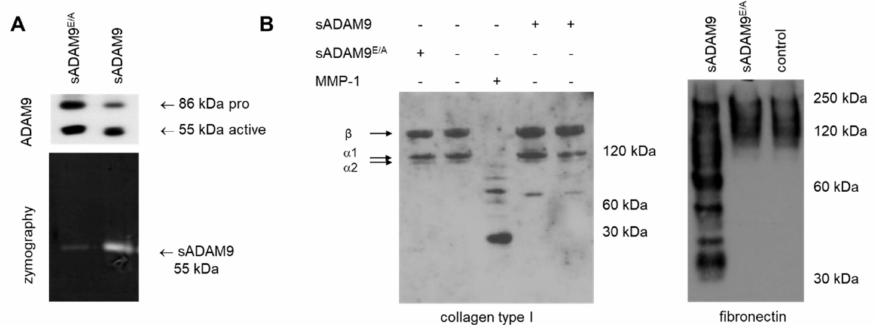
Figure 3. Collagen type I is a substrate of recombinant ADAM9 ( A ) Upper insert, detection of purified ADAM9 by western blot using anti-ADAM9 antibodies. In the lower panel, gelatin zymography analysis shows the high gelatinolytic activity of the catalytic active 55 kDa (sADAM9) and low of the catalytically inactive ADAM9 (sADAM9E / A). ( B ) Enzymatic processing of fibronectin or collagen type I by recombinant ADAM9s as assessed by immunoblotting. 500 ng of recombinant collagen type I or fibronectin were incubated alone (control, − ) or without ( − ) and with one µ g of recombinant sADAM9 or sADAM9E / A ( + ) for 16 h in substrate bu ff er. Incubation of collagen with 500 ng MMP-1 used as a positive control. Molecular weight markers are on the